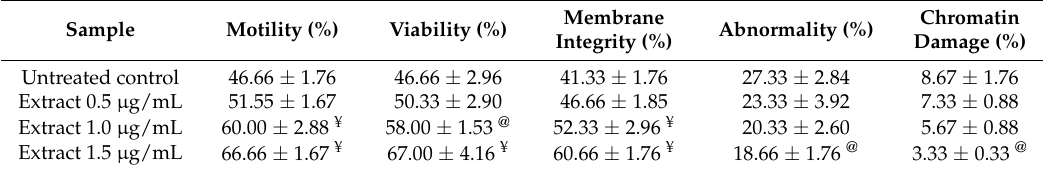
Table 4. Effect of A. harveyi leaf extract on sperm characteristics of bull frozen-thawed semen.